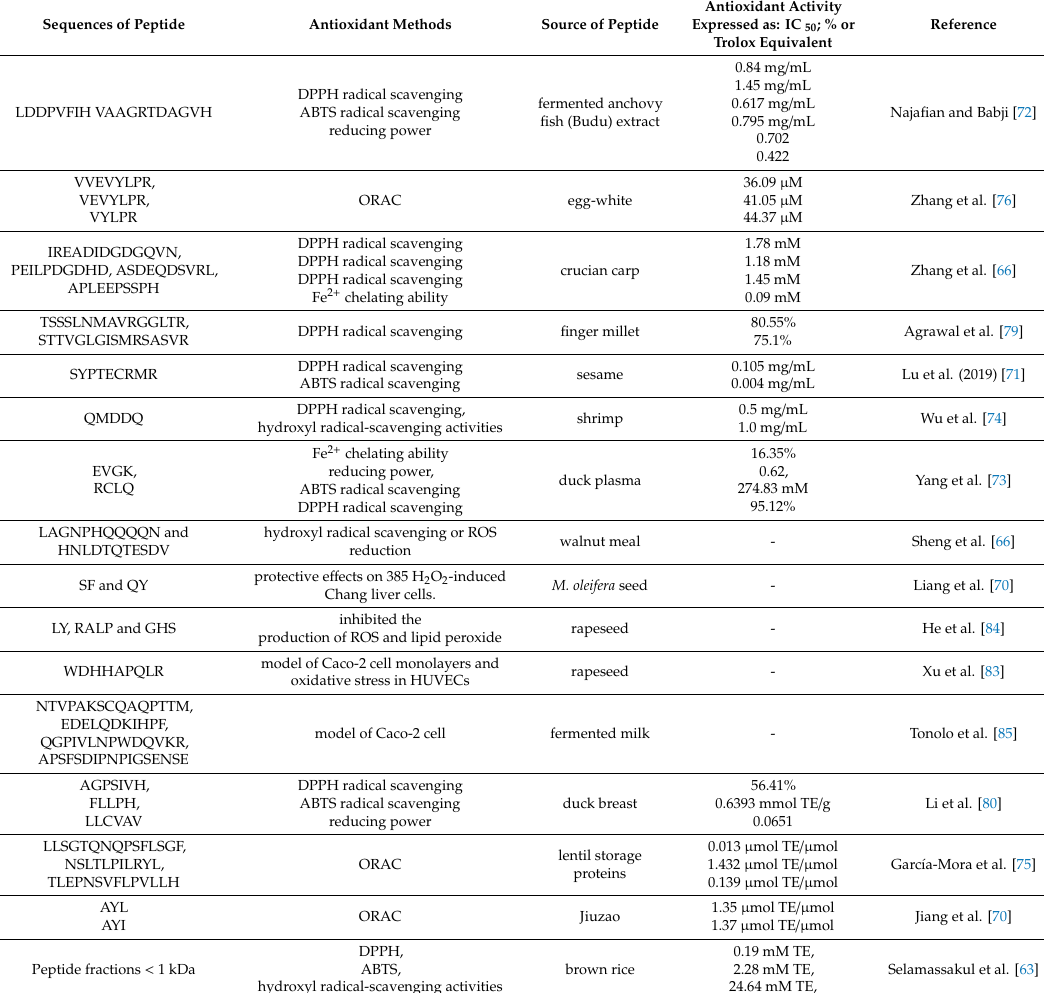
Table 2. Peptide sequences with antioxidant